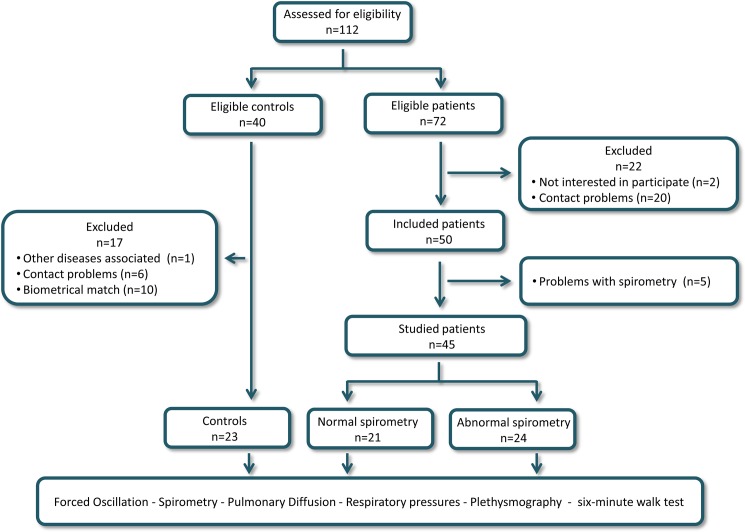
Study flowchart describing the examined volunteers and the sequence of the performed analysis.